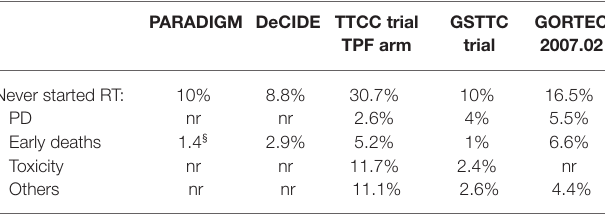
TABLE 3 | Proportion of patients not receiving concomitant treatment after induction